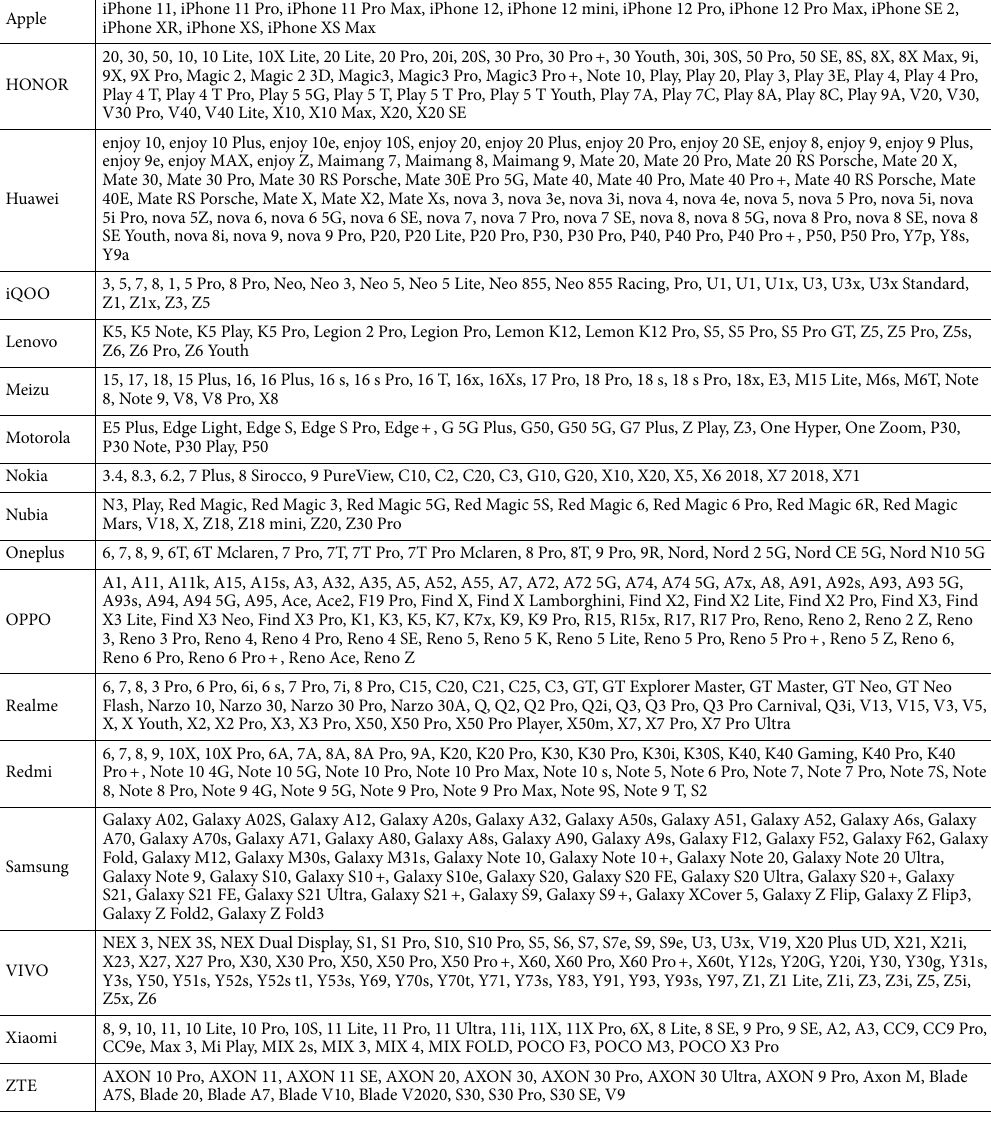
Table 1. Brands and models of